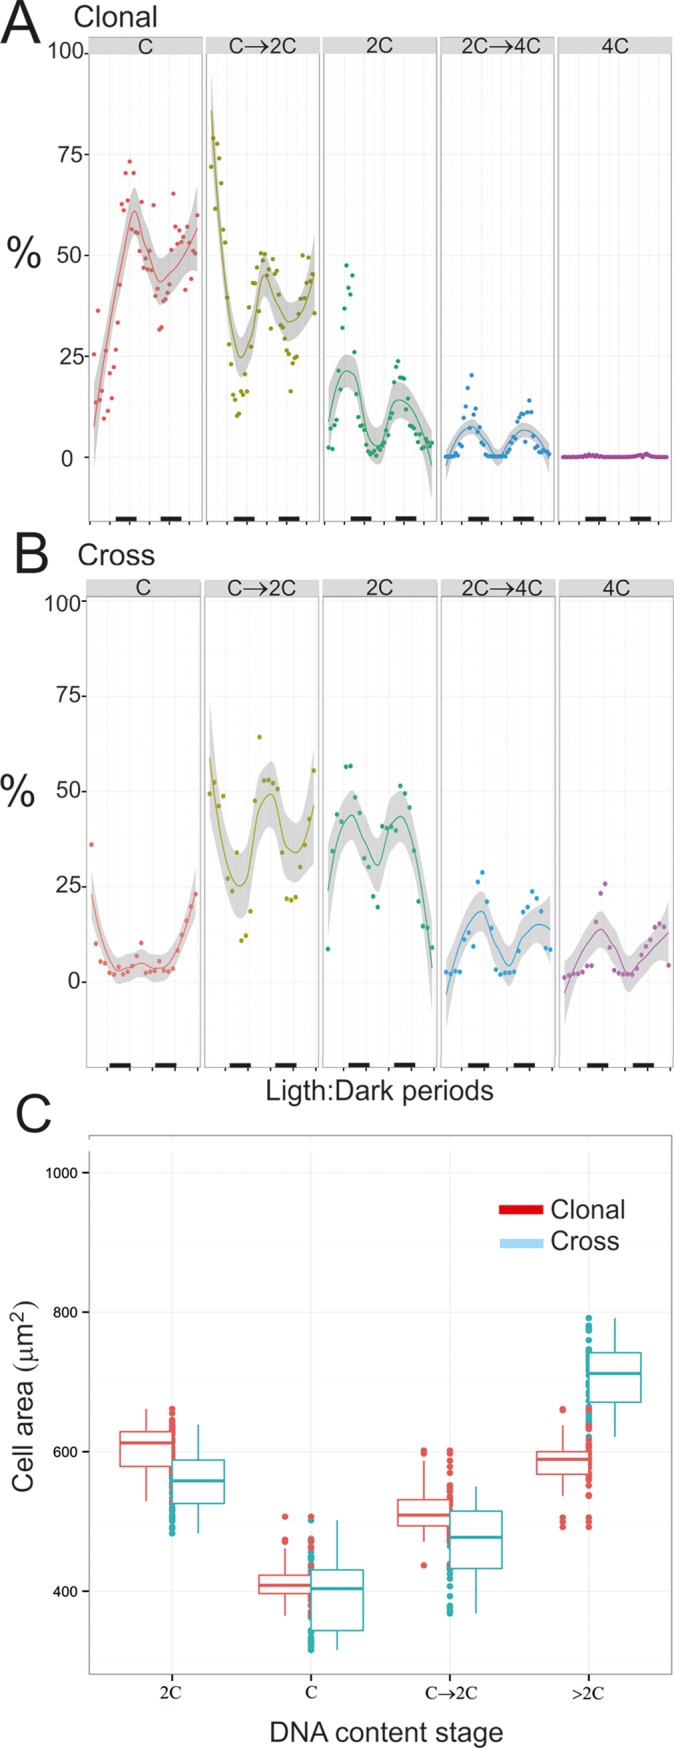
Comparisons between clonal and cross cultures.Percentage of cells in each cell cycle stage in the clonal culture (A) vs. the cross culture (B) during two L:D periods as shown by a trend line and the standard error (gray-shaded area). The dark bars along the bottom indicate the dark period. (C). Box-and-whisker plots comparing cell areas in the cell phases of clonal vs. cross culture.